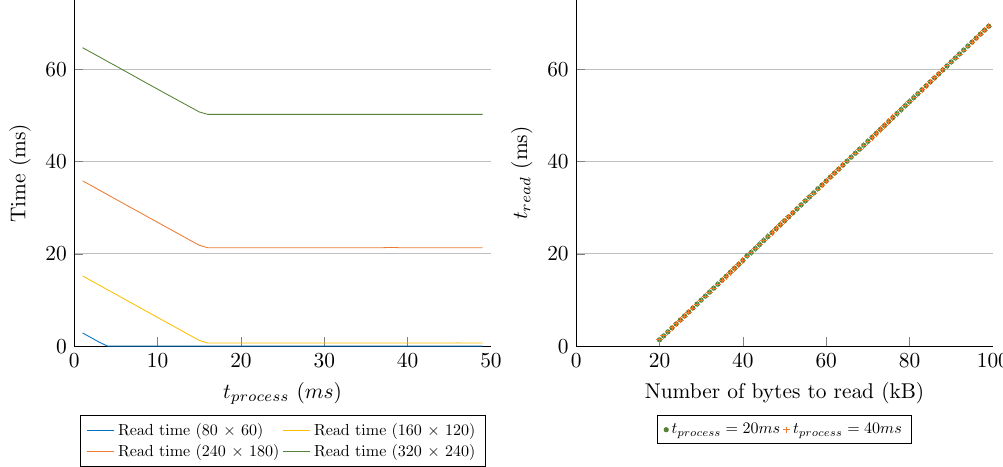
Figure 12. On the left, time to read data from the buffer for different resolutions. The function “usleep” is used to control t process for different resolutions. The read time for the higher resolutions decreases up to t process equal to 16 ms. After this, the read time becomes constant. This is due to the buffer containing the same amount of data when the read call starts (the maximum it can contain). On the right, time to read different amounts of bytes from the buffer. t process is kept constant to 20 ms and 40 ms and the read time is measured. The read times for both the 20 ms and 40 ms are the same for the same amount of bytes. The graphs has a linear trend line of y = 0.8599 x 15806 with R 2 = 1. One can see that this trend line − gives a relationship between the size of the buffer (around 16 kB) and the time to generate one byte by the FPGA (0.85 µ